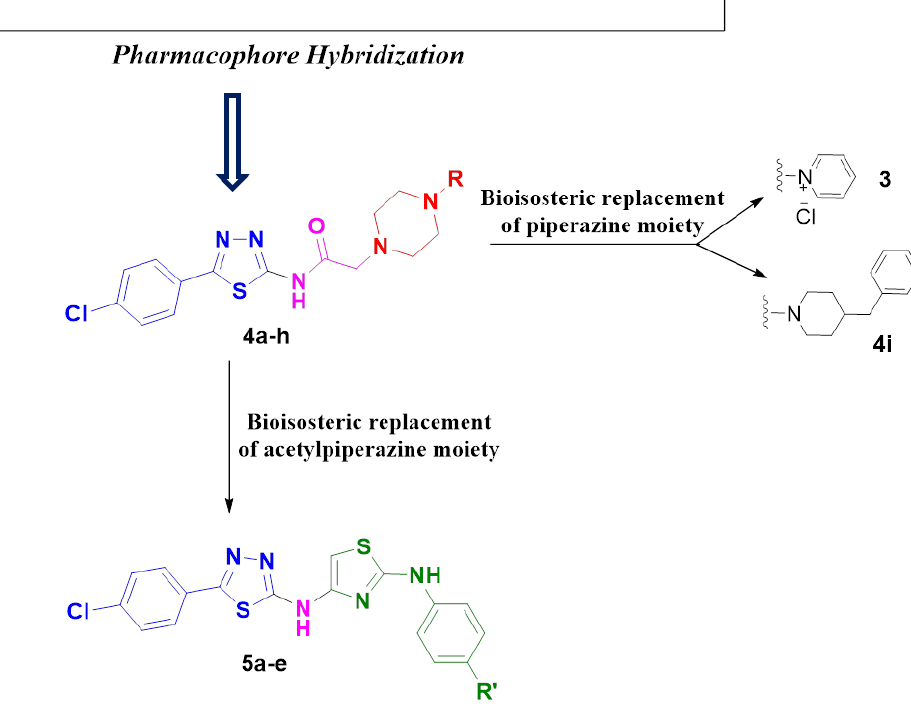
Figure 3. Design of target compounds 3, 4a-i , and 5a-e.